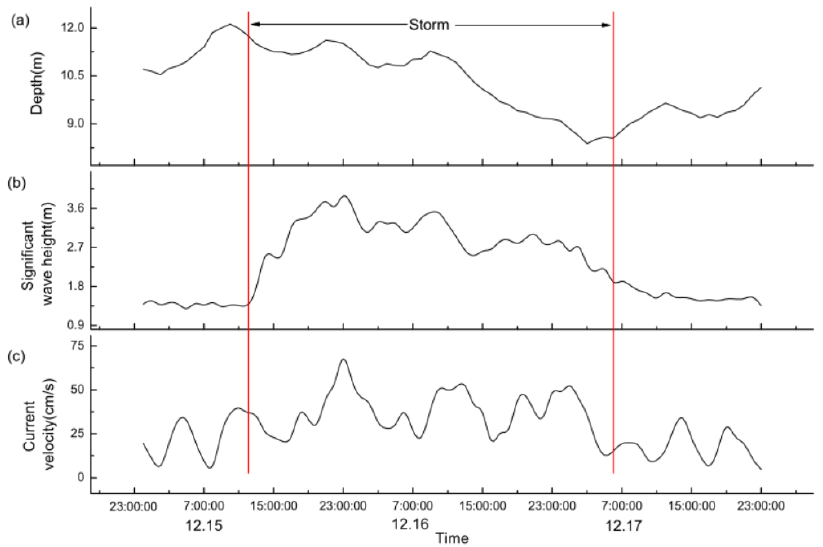
Figure 3. ( a ) Depth, ( b ) significant wave height, and ( c ) current velocity from 15 – 17 December 2014.